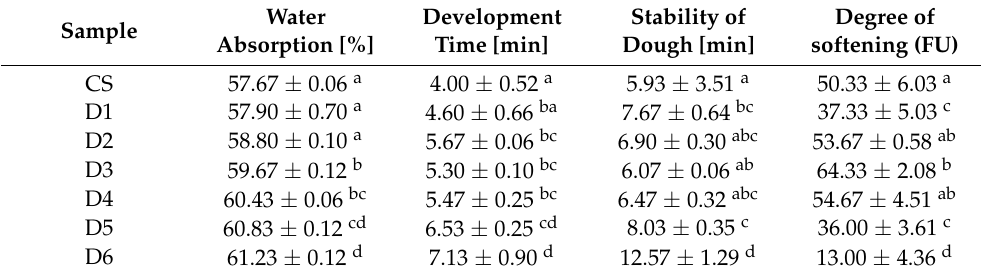
Table 2. Physical properties of control wheat dough and DF-enriched dough samples.